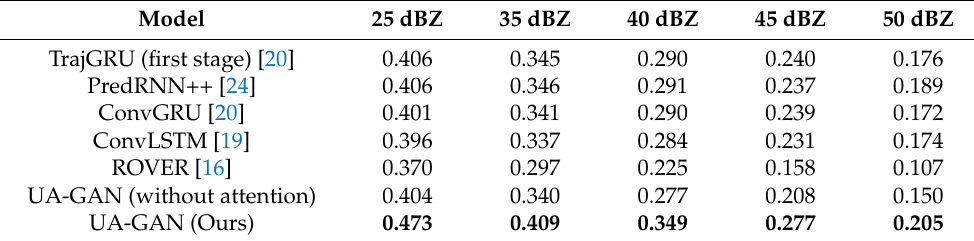
Table 11. Scores of HSS( ↑ ) at echo thresholds = 25, 35, 40, 45, and 50 dBZ.